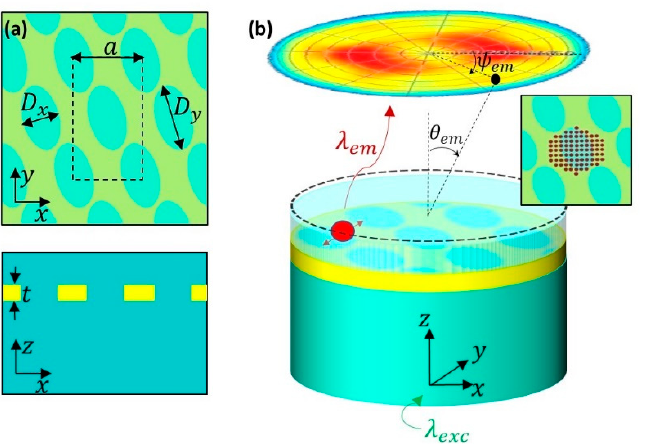
Figure 1. ( a ) xy- and xz-plane views of the ENHA, with geometric parameters. The dashed region in the top schematic shows the unit cell used in the “passive” simulations. ( b ) Simulation set-up for the “active” simulations; the randomly oriented dipole is positioned inside the embedding medium, 20 nm above the ENHA, and at a distance from the center which corresponds to one of the points in the inset. The dipole emits at a single wavelength λ em . The electromagnetic field at the excitation wavelength λ exc is further introduced as an additional tuning and optimization